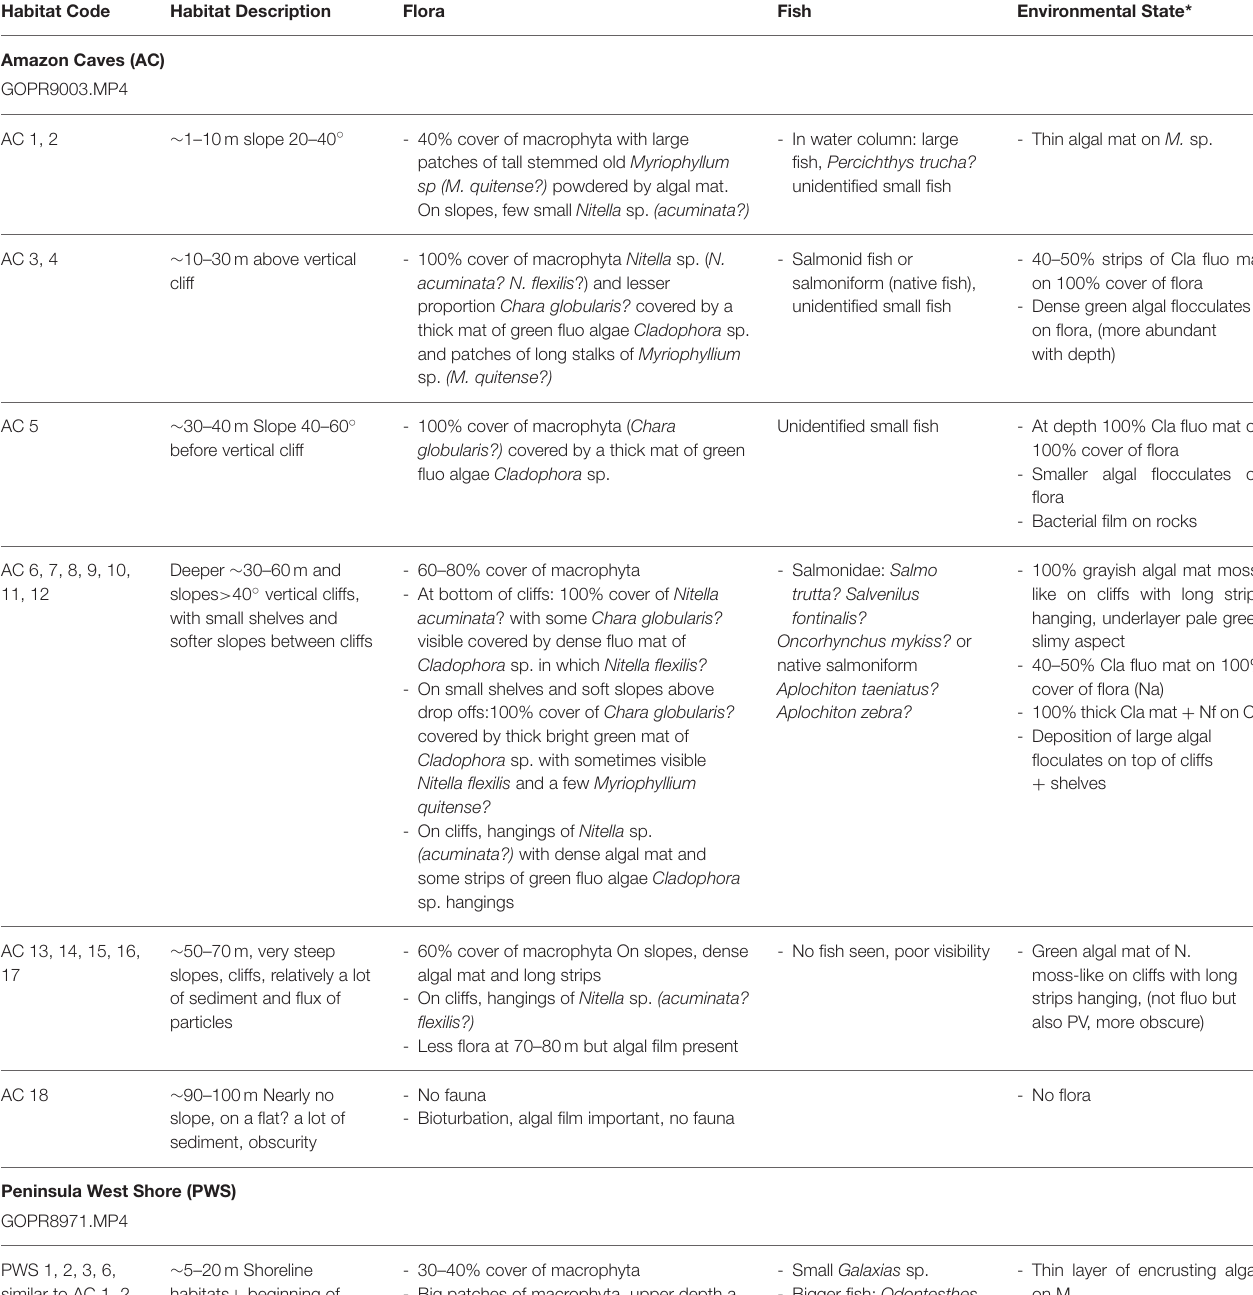
TABLE 3 | Summary of distinct habitats and associated species of macrophytes and fish observed on the video transects at Amazon Caves (5 to 90–100m) and Peninsula West Shore (5 to 40–50m). Habitat Code Habitat Description Flora Fish Environmental